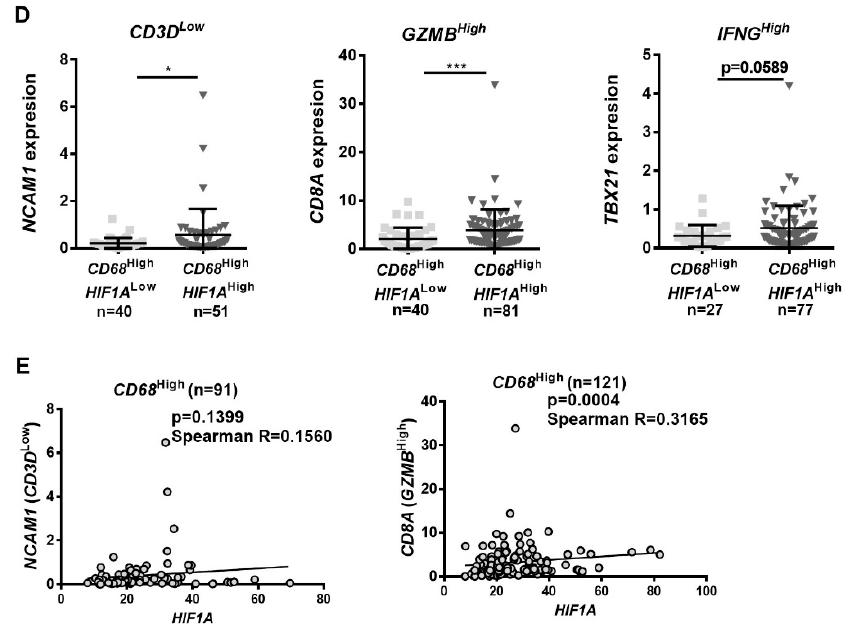
Figure 6. CD68 High HIF1A High tumors present increased expression of pro-inflammatory cytokines and increased infiltration of cytotoxic T-cells. RNASeq expression data were downloaded from TCGA. ( A ) The expression of IL1B , IL6 , and TNF was evaluated within the CD68 High population, between HIF1A Low and HIF1A High , according to the median levels of CD68 and HIF1A expression in normal samples. ( B ) The correlation between IL1B , IL6 , TNF , and HIF1A was assessed within the CD68 High population. ( C ) IL-1 β protein levels were evaluated in total lysates from co-cultured RKO cells (RKO CC) and macrophages (MAC CC), by Western blot, and band densitometry quantification presented. Hsc70 was used as loading control, and the figure is representative of 3 independent experiments. ( D ) The expressions of NCAM1 , CD8A , and TBX21 were evaluated within the CD68 High population, between HIF1A Low and HIF1A High subpopulations, according to the median levels of CD68 and HIF1A expression in normal samples. NCAM1 levels were evaluated within the CD3D Low population, CD8A levels were evaluated within the GZMB High population, and TBX21 levels were evaluated within the IFNG High population. CD3D Low , GZMB High , and IFNG High populations were established according to the NCAM1 ( CD3D Low ), CD8A ( GZMB High ), and HIF1A were assessed within the CD68 High